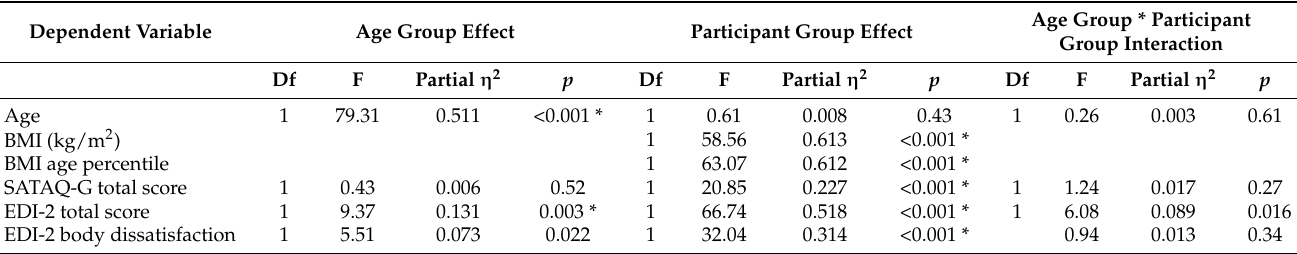
Table 2. Results of univariate ANOVA regarding participant characteristics (* significant p values after Bonferroni correction ( α ’ < 0.01); BMI = body mass index, EDI-2 = Eating Disorder Inventory-2, SATAQ-G = German version of the Social Attitudes Towards Appearance Questionnaire).